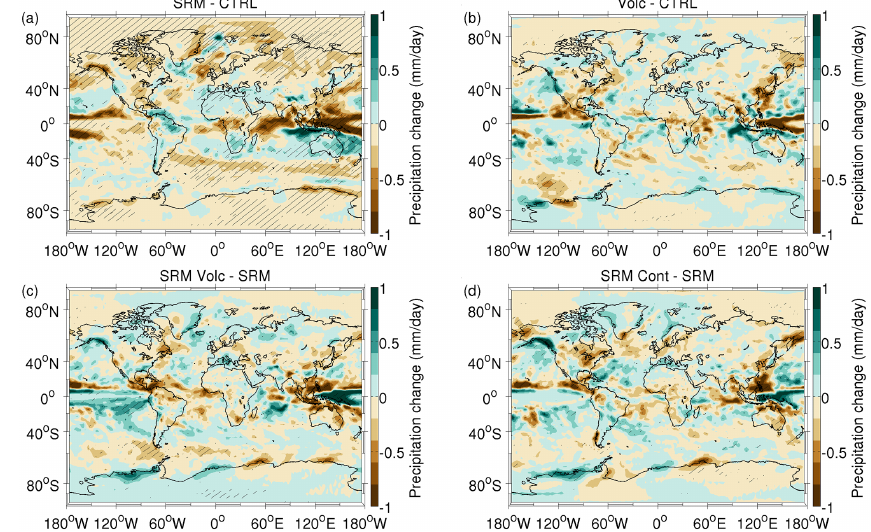
Figure 6. Ensemble-mean precipitation change in (a) 50-year mean precipitation change in the SRM scenario. The change in 1 year mean precipitation after the volcanic eruption in (b) Volc, (c) SRM Volc and (d) SRM Cont compared to the pre-eruption climate (CTRL for SRM and Volc, and SRM for SRM Volc and SRM Cont). Panels (b–d) show the 1-year-mean temperature after the eruption. Panel (a) shows the mean over the corresponding 1-year-periods as the other panels. Hatching indicates a regions where the change of precipitation is statistically significant at 95% level. Significance level was estimated using Student’s unpaired t test with a sample of 10 ensemble member means for panels (b–d) and a sample of 50 annual means for panel (a)